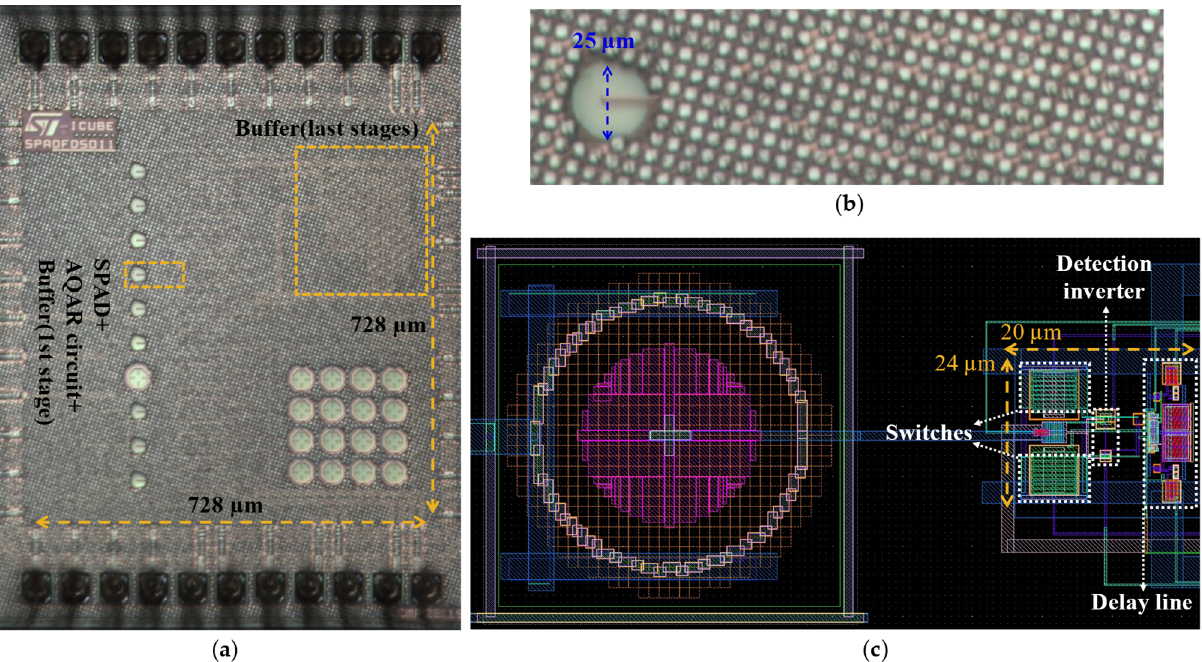
Figure 8. ( a ) Micrograph of the full chip; ( b ) the used pixel in this work; ( c ) layout view of the proposed pixel.